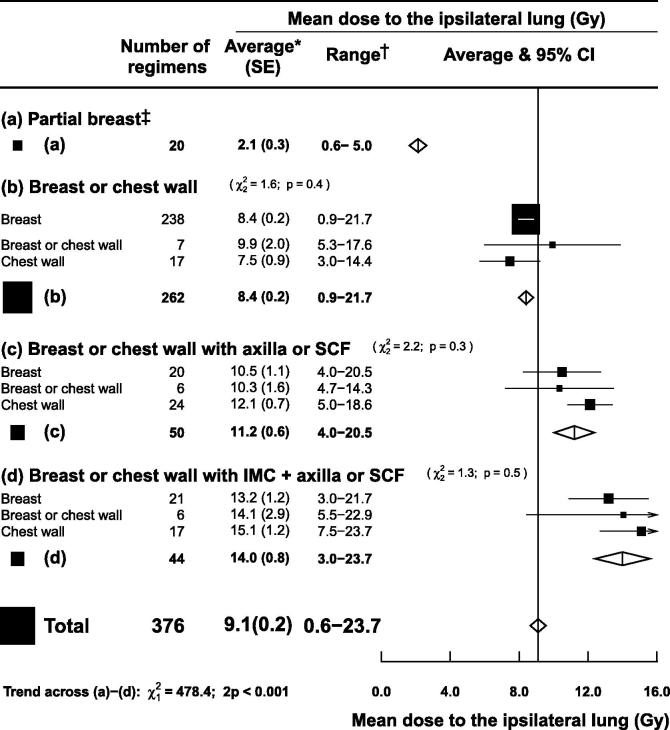
Mean ipsilateral lung dose (MLDipsi) from left or right breast cancer radiotherapy according to regions irradiated. Studies of women with unfavourable anatomy were excluded as were regimens using prone or lateral decubitus positioning, and regimens irradiating the internal mammary chain (IMC) but not the axilla or the supraclavicular fossa (SCF). *Average of mean ipsilateral lung doses for reported regimens. †Range of mean ipsilateral lung doses for reported regimens. χ2 and p values are for heterogeneity. Abbreviations: SE: standard error; CI: confidence interval.